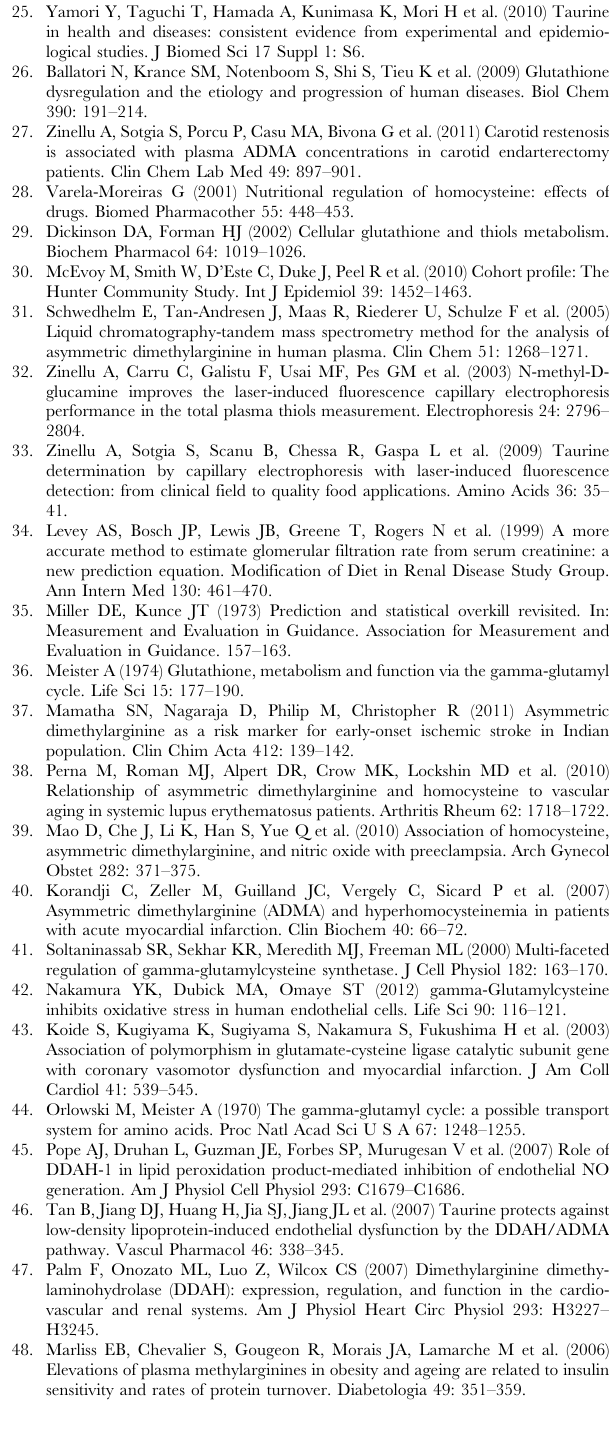
Figure S2 Scatter plots between individual serum thiols and SDMA